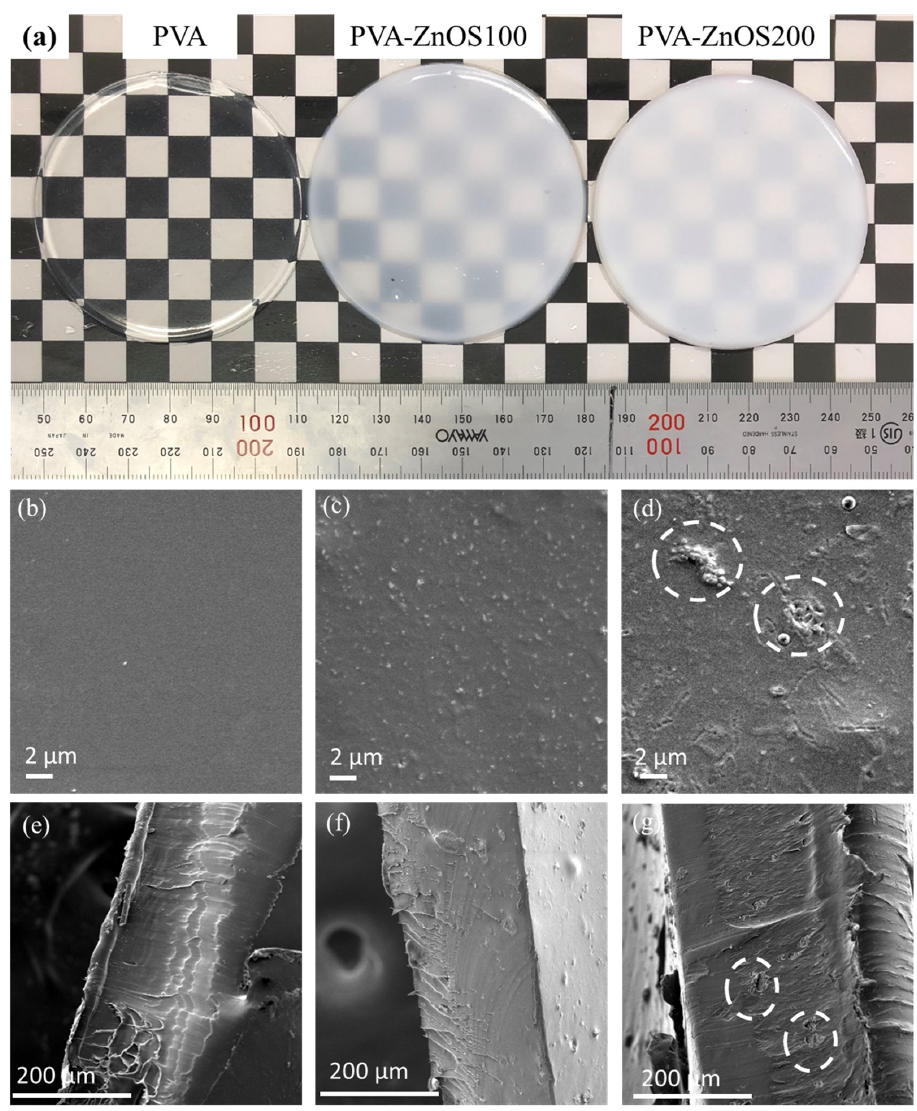
Figure 2. ( a ) photographs of PVA, PVA ‐ ZnOS100, and PVA ‐ ZnOS200; SEM images of surfaces ( b – d ) and cross ‐ section ( e – g ) of PVA, PVA ‐ ZnOS100, and PVA ‐ ZnOS200 . The optical properties of gels were studied by UV ‐ vis absorption spectra shown in Figure 3b. No noticeable absorption from UV to visible ranges was observed with pure PVA gel. Commonly, it was seen that ZnOS absorbed UV ranges (<400 nm), which resem ‐ bled PVA ‐ ZnOS. From the UV ‐ absorption spectrum, bandgap energy was calculated based on a Tauc plot (Figure S3). It is seen that there were two absorption bands at 3.30 and 3.55 eV, which correspond to the bandgap energy of ZnO and ZnS, respectively. This evidenced that the synthesized sample was composed of ZnO and ZnS phases, which agreed with the XRD pattern. The characteristic absorption of ZnO/ZnS ‐ PVA mainly orig ‐ inated from bandgap absorption of ZnO and ZnS semiconductors because pure PVA does not have such characteristic absorption. Fourier Transform Infrared (FTIR) spectroscopy of pure PVA and PVA ‐ ZnOS showed the chemical bonding modes of the polymers ʹ func ‐ tional groups (Figure 3c). The broad peak at 3000–3600 cm − 1 is attributed to an absorption peak of the OH functional group of PVA, originating from intermolecular and intramo ‐